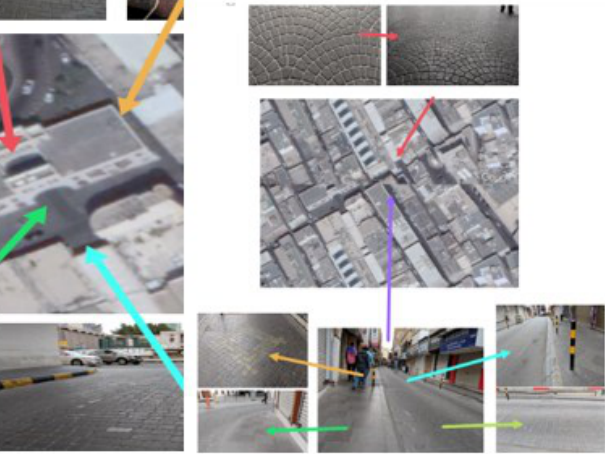
Figure 10. Pavement design and distribution (Researcher).